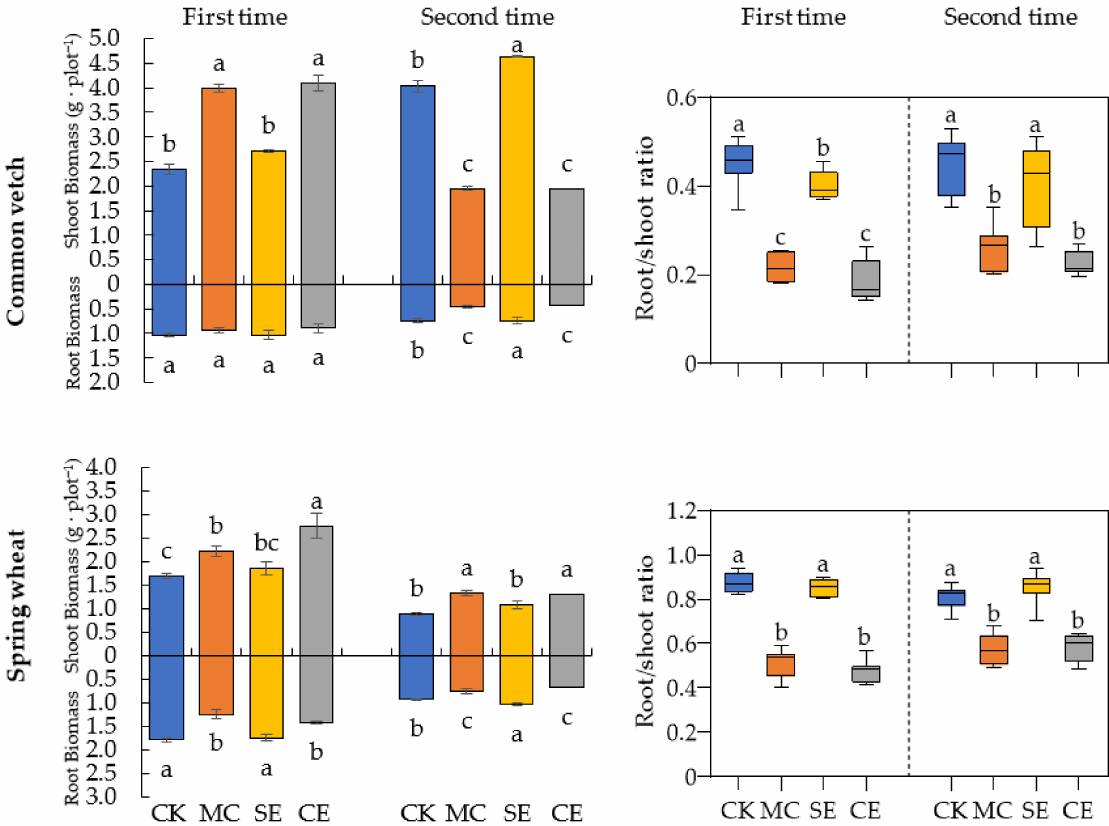
Figure 1. Root biomass and shoot biomass and root/shoot ratio of the two forage crops. The significant differences were labeled with letters using Duncan’s notation, from largest to smallest: a, b, c, d. If there is no significant difference between two values, the same or overlapping letters are used for both